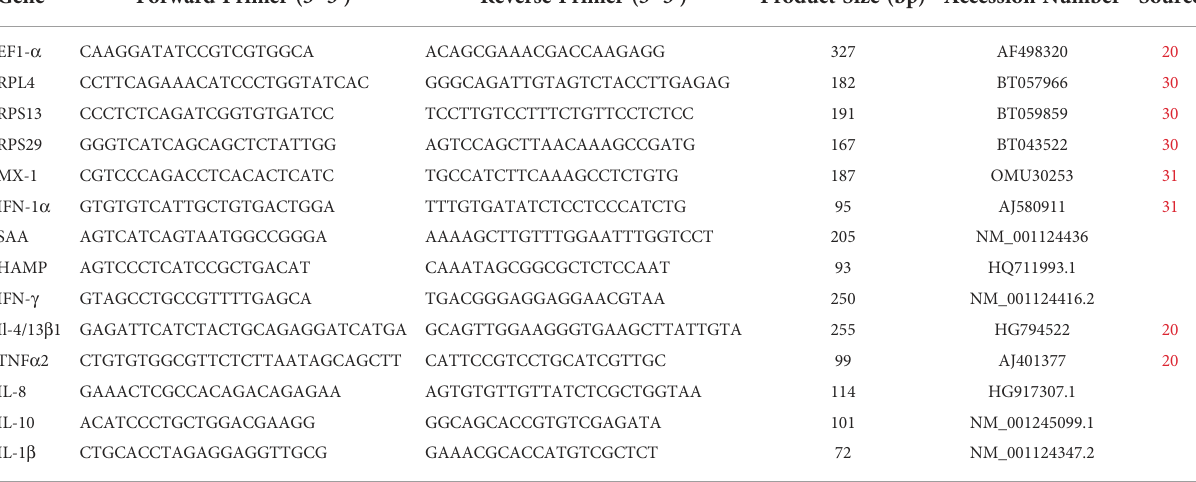
TABLE 1 Primers used for qPCR